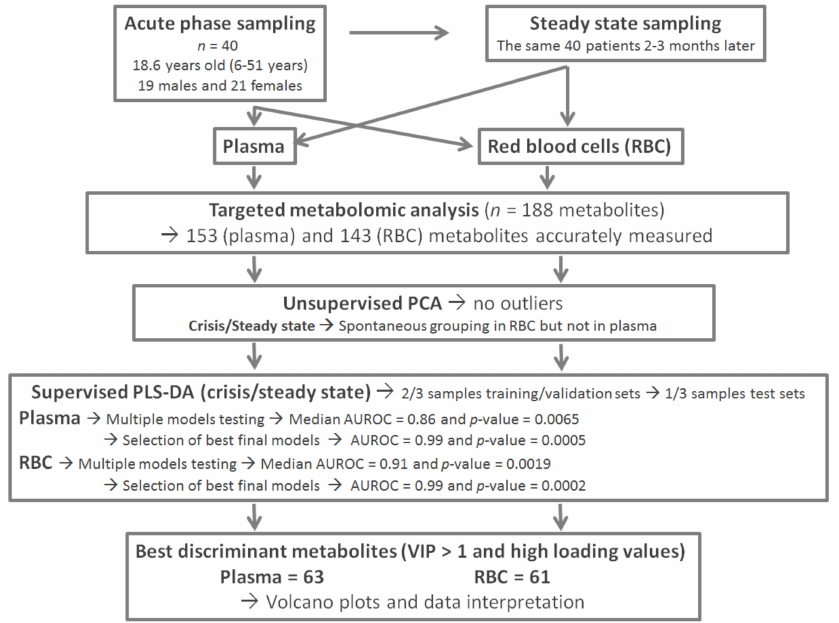
Figure 1. Global flow chart and study